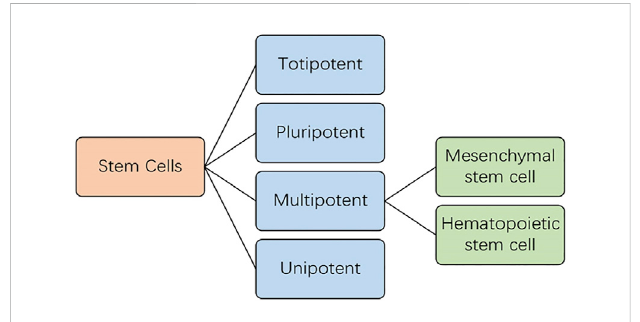
FIGURE 1 Stem cells are classi fi ed according to their developmental